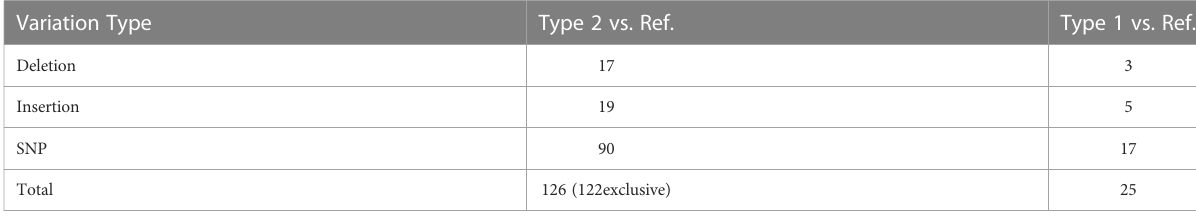
TABLE 2 Total counts of variation in the chloroplast genomes by Calling SNPs with Samtools when aligning the cpDNA of Type 1 and Type 2 plants to the previously published marama reference chloroplast genome (KX792933.1).